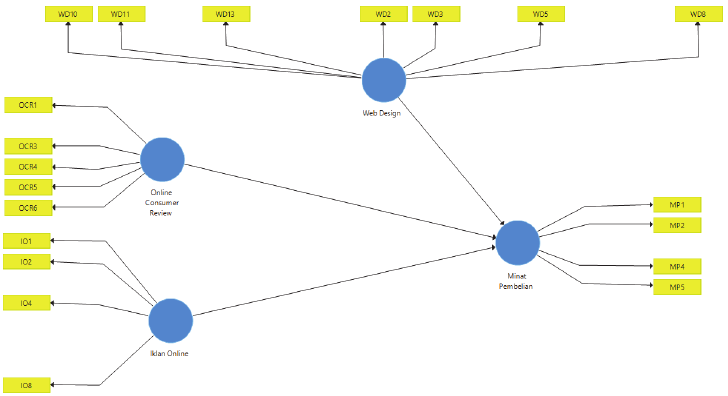
Fig. 2. Results of PLS Algorithm